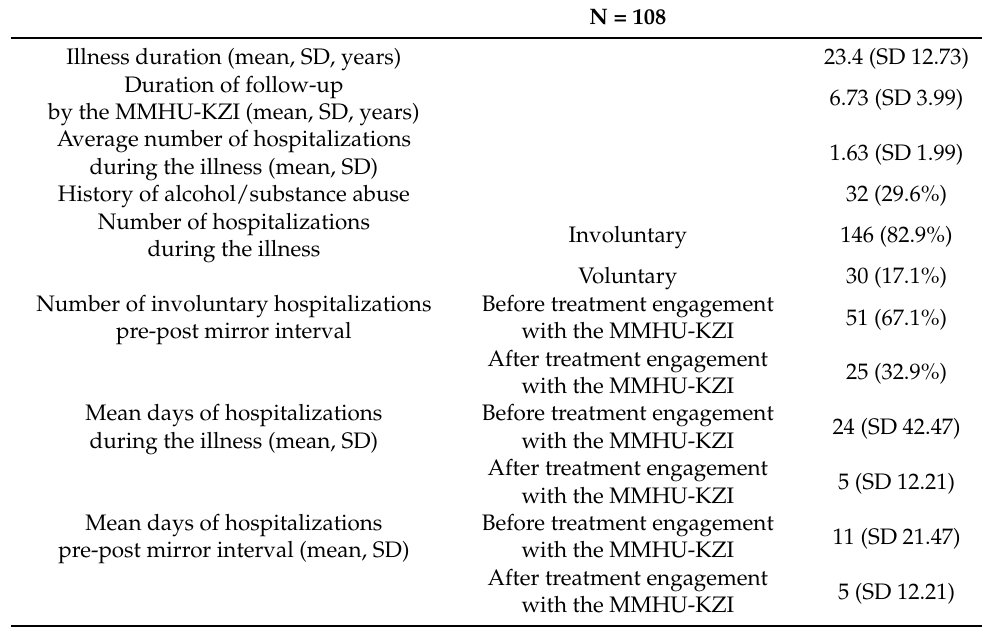
Table 3. Patients’ clinical